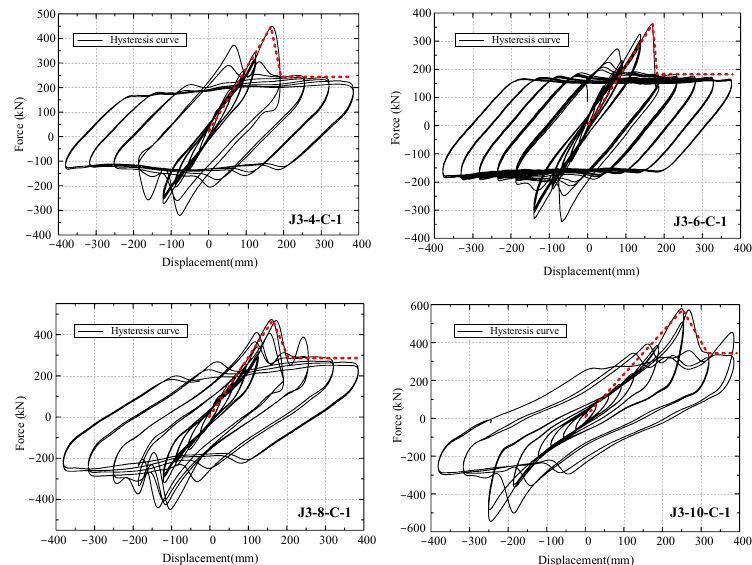
Figure 7. Force-displacement curves of LRBs at concrete friction interface.